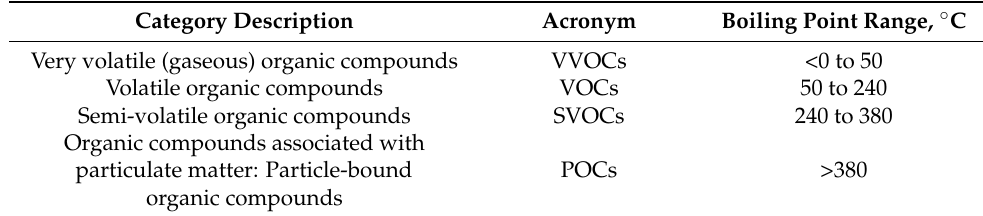
Table 1. World Health Organization (WHO) classification of volatile organic compounds (VOCs) adapted from